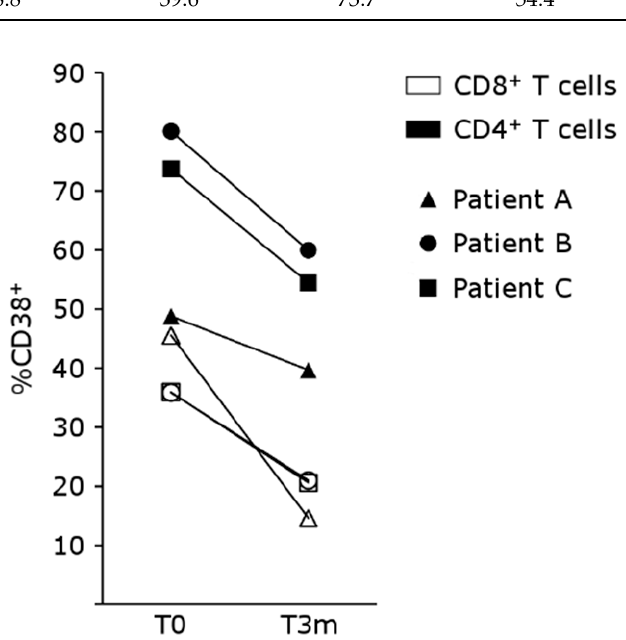
Figure 6. CD38 expression on CD4 + or CD8 + T cells from patients treated with belatacept, before (T0) or 3 months after (T3m) the introduction of everolimus ( n = 3 patients).